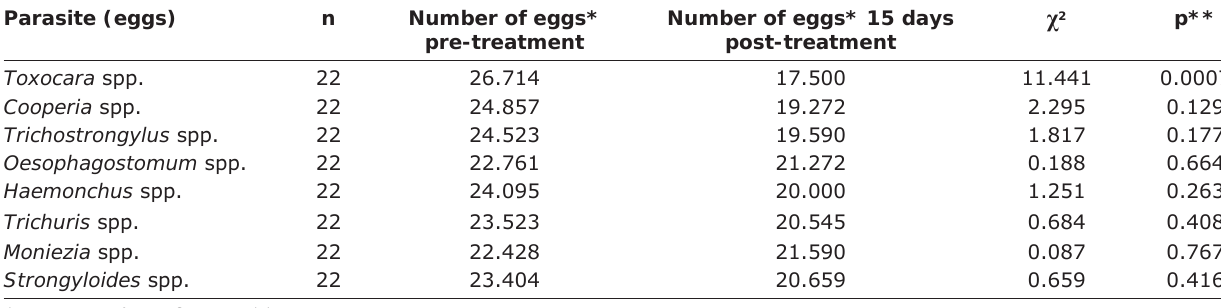
χ 2 p** Number of eggs* 15 days pre-treatment post-treatment